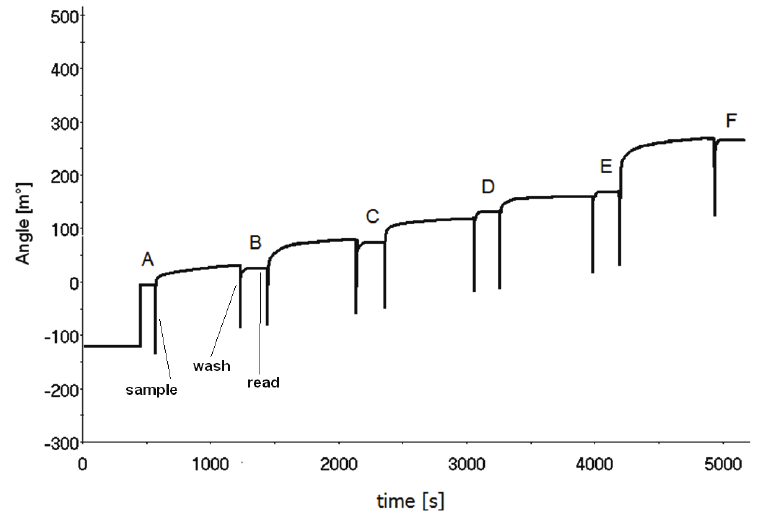
Figure 6. Real time response of the immunosensor measured by SPR: in PBS ( A ); in the in concentrations:10 pg/mL (0.13 pM), 30 pg/mL presence of antigen protein rSPI2-His 6 (0.39 pM), 100 pg/mL (1.31 pM), 300 pg/mL (3.93 pM) and 1 ng/mL (13.10 pM). Solution composition: rSPI2-His protein in PBS pH 7.4 (137 mM NaCl, 10 mM 6 phosphate, 2.7 mM KCl).